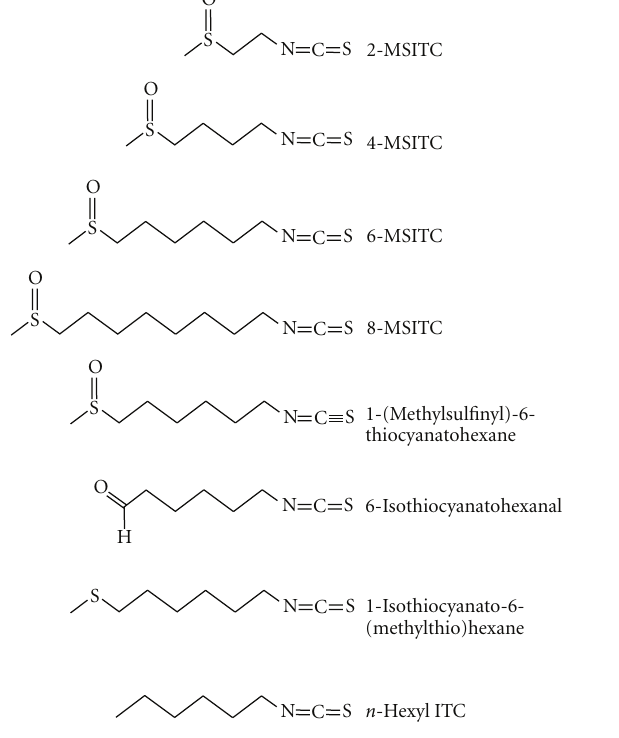
Figure 3: Chemical structures of analogues of 6-MSITC. 4-MSITC (sulforaphane), 2-MSITC, and 8-MSITC are analogues of 6-MSITC containing the di ff erent length of alkyl chain. 1-(Methylsulfinyl)- 6-thiocyanatohexane substituted ITC group in 6-MSITC with thiocyanate group. 6-Isothiocyanatohexanal, 1-isothiocyanato-6- (methylthio)hexane, and n -hexyl ITC substituted the methylsulfinyl group in 6-MSITC with formyl group, methylsulfinyl group, and methyl group,